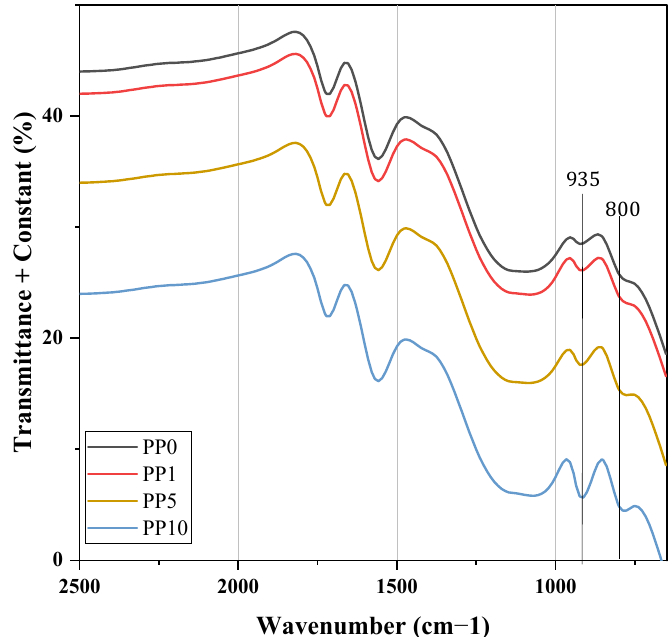
Figure 4. infrared spectra of the catalyst with distinct levels of arsine. Figure 4. Infrared spectra of the catalyst with distinct levels of